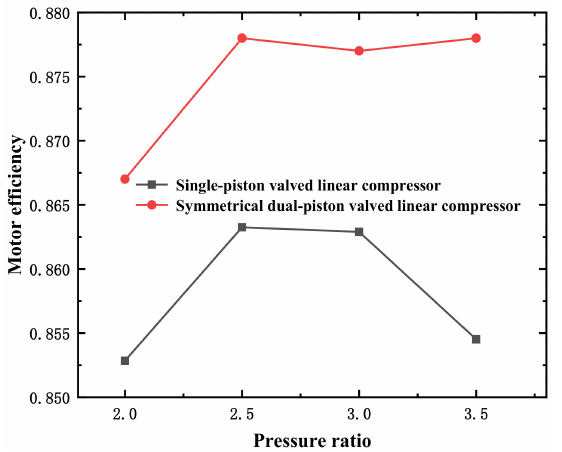
Figure 19. The motor efficiencies of the two types of linear compressors at different pressure ratios, obtained from the